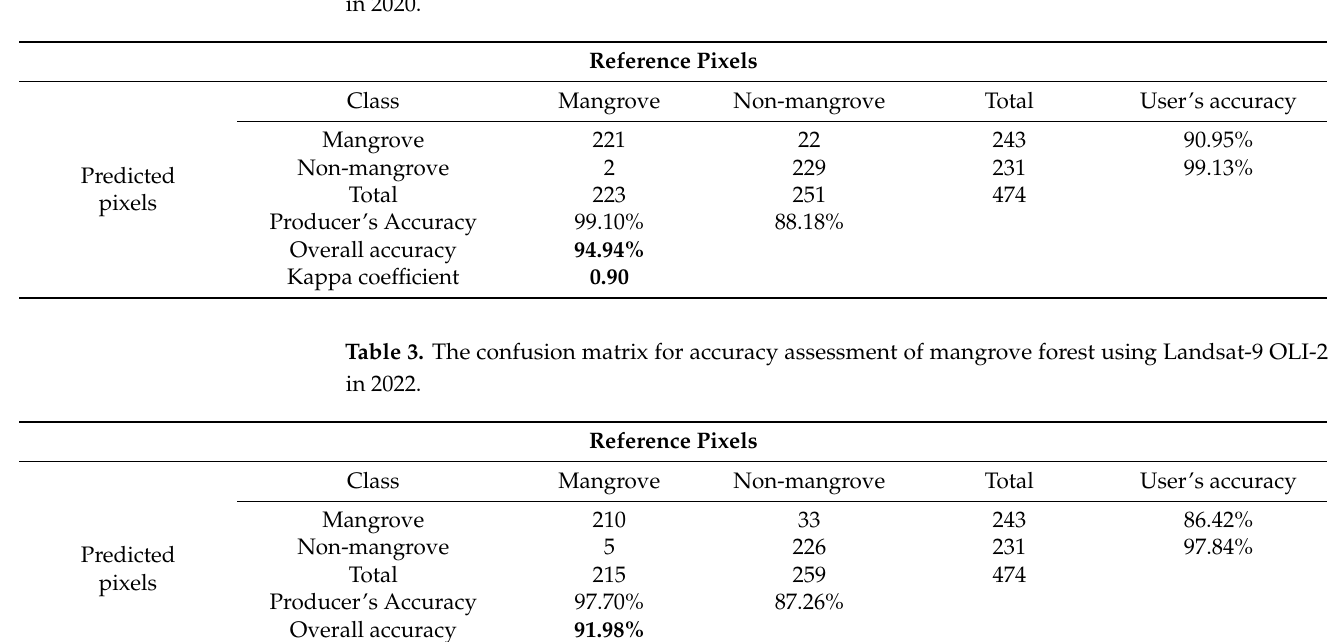
Table 3. The confusion matrix for accuracy assessment of mangrove forest using Landsat-9 OLI-2 in 2022.